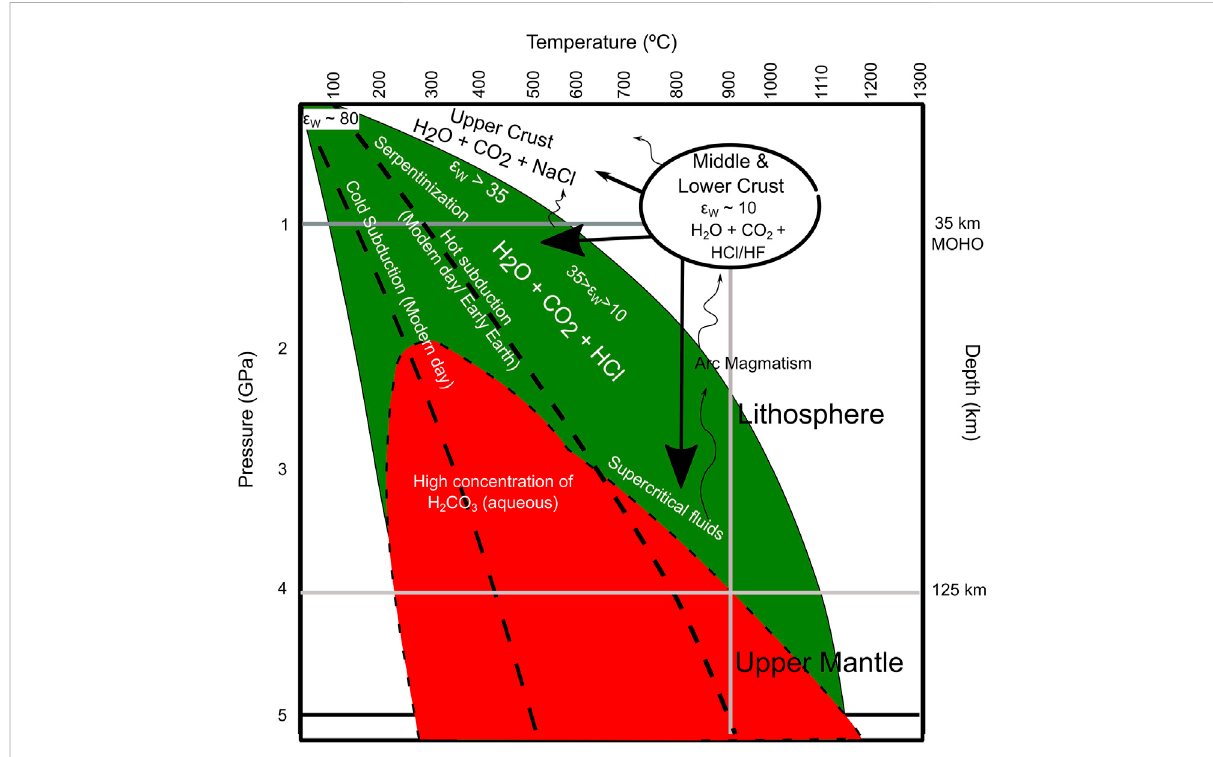
Schematic diagram representing P-T conditions of acidic CO 2 -H 2 O-HCl-HF fl uids in lower crust, subduction zone, and upper mantle. Where ε ε W is dielectric constant of water. Our results of acidic conditions at lower crust, where W ~ 10 suggest that dissociation constant of solutes is moderately high in water (K HCl/HF ) at the lower crustal conditions. Therefore, below ~800 ° C and above 1GPa, acidic CO 2 -H 2 O-HCl-HF fl uids could exist in most of the subduction zone (both cold and hot subduction existed throughout Earth ’ s history and today (Thompson, 1992)) and upper mantle conditions. Concentration of carbonic acid (red area) increase above 2.4 GPa and 250 ° C in most of the upper mantle conditions (Pan and Galli,2016;StolteandPan,2019).Therefore,Earth ’ sinteriorismostlyacidicindehydrationreactions(ifmineralsincorporate signi fi cantamount ofCl and CO 2 ) below Mohorovicic Discontinuity